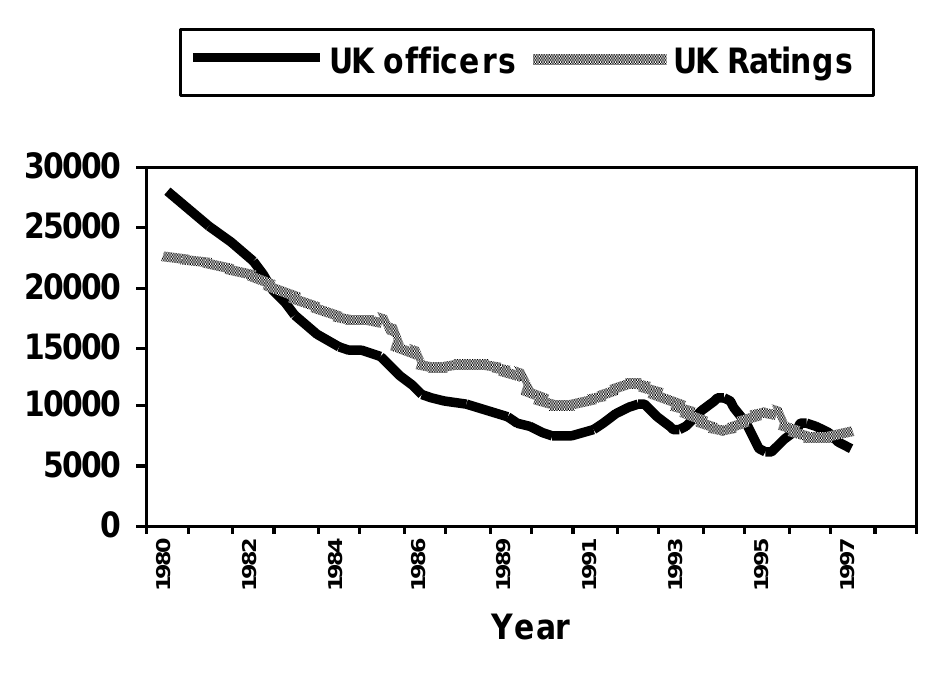
Figure 1. British Officers and Ratings Serving in the Merchant Marine from 1980 to